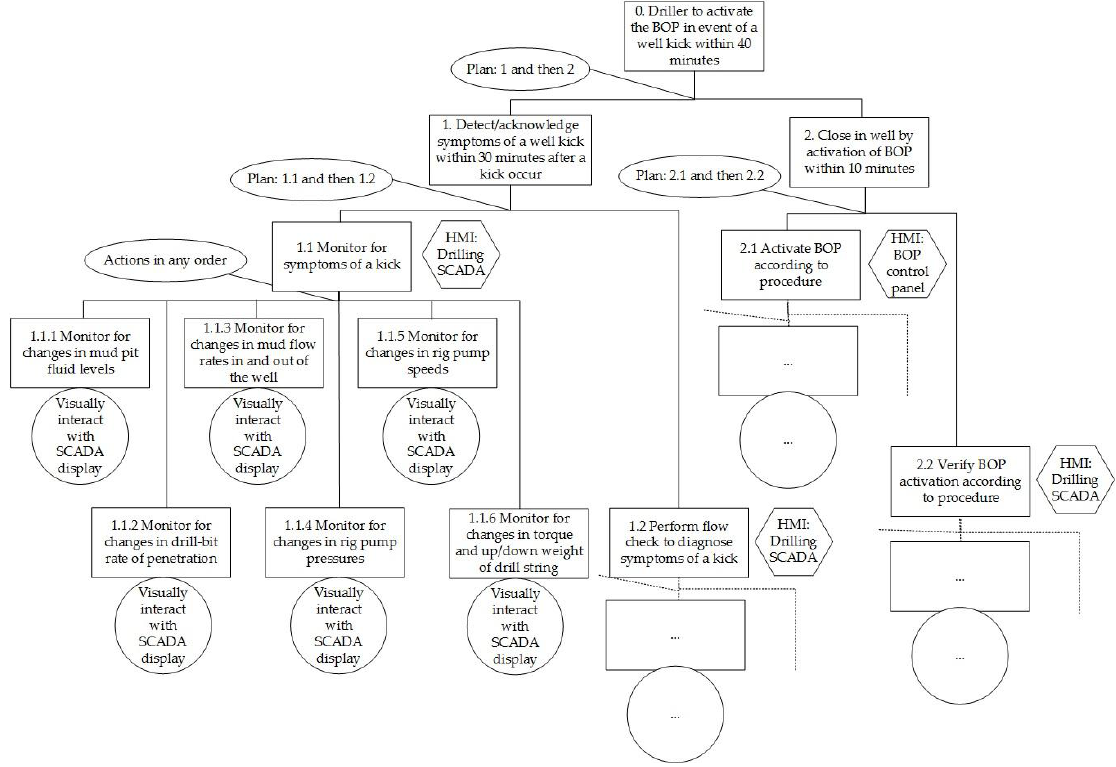
Figure 7. HTA in task analysis of offshore drilling activity.